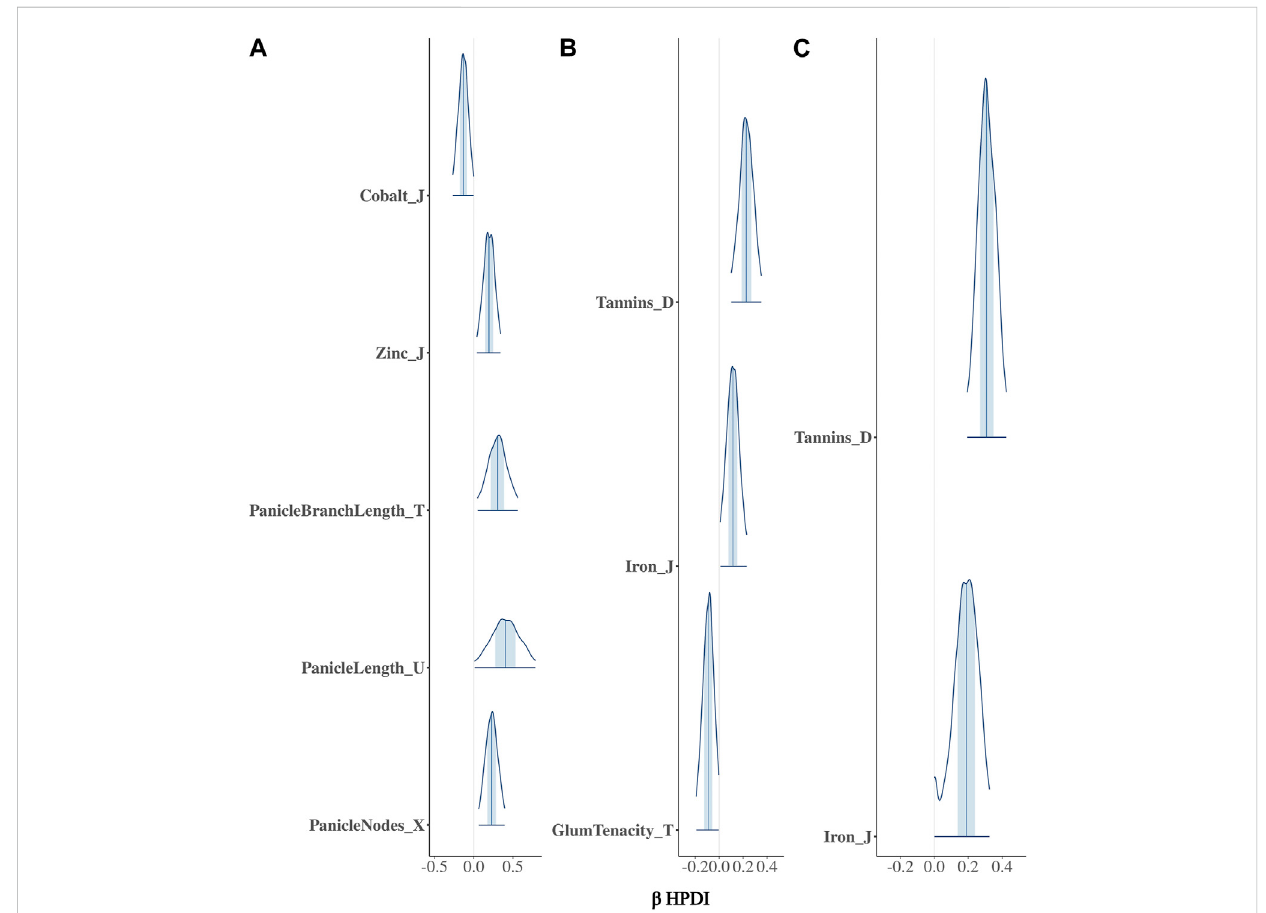
FIGURE 2 Posterior estimates of β for traits signi fi cantly associated with Tan2 (Chr2:7,976,118) using (A) Bayesian Ridge, (B) Lasso, and (C) Horseshoe Regression. Histograms represent the 95% highest posterior density interval (HPDI) based on MCMC